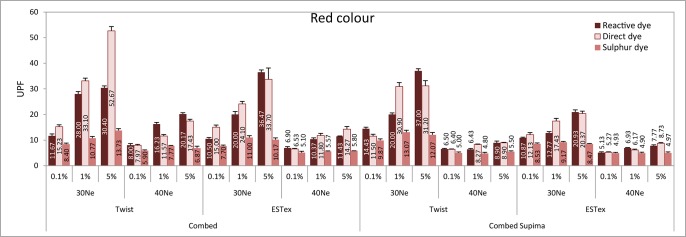
UPF values of various fabrics in red colour.